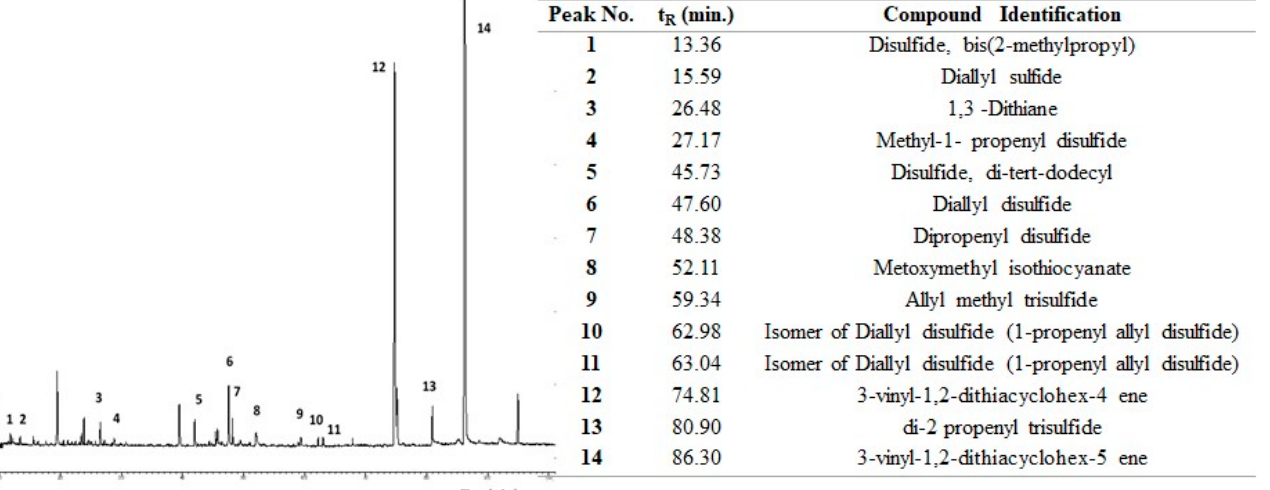
Table 1. Organosulfur compound compositions in fresh Voghiera garlic hydro ‐ alcoholic extract and